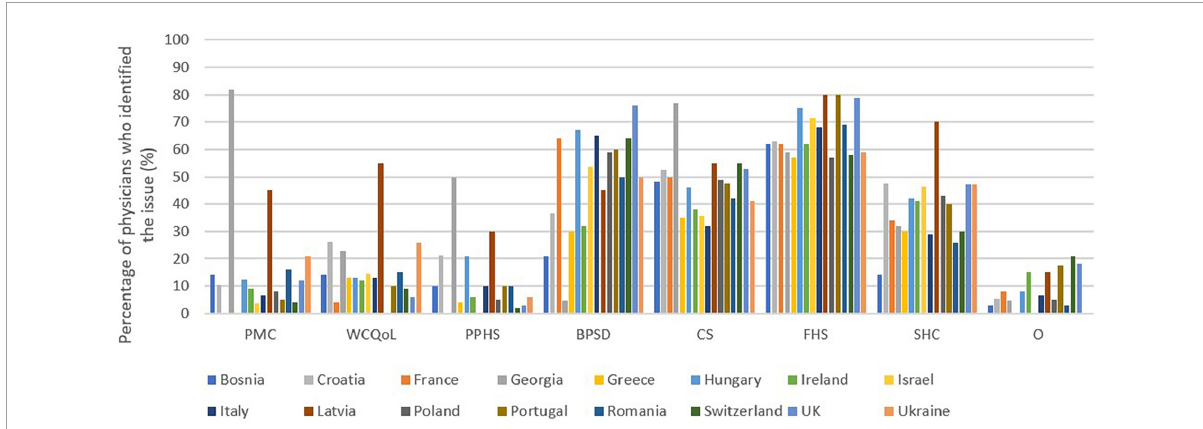
FIGURE3 Intermediate care: Main disadvantages declared by general practitioners. PMC, Poor medical care of the patient; WCQoL, Decrease in the quality of life of the caregiver; PPHS, Poor prognosis of the patient’s state of health; BPSD: Disorientation and exacerbation of behavioral and psychological symptoms of dementia because the patient has been transferred to another living environment. CS: Feeling of shame on the part of the caregiver (s) for not being able to take care of the patient (s) themselves (“natural” obligation according to social conventions). FHC, High cost for the family; SHC, High cost for society and the healthcare system; O: Others.